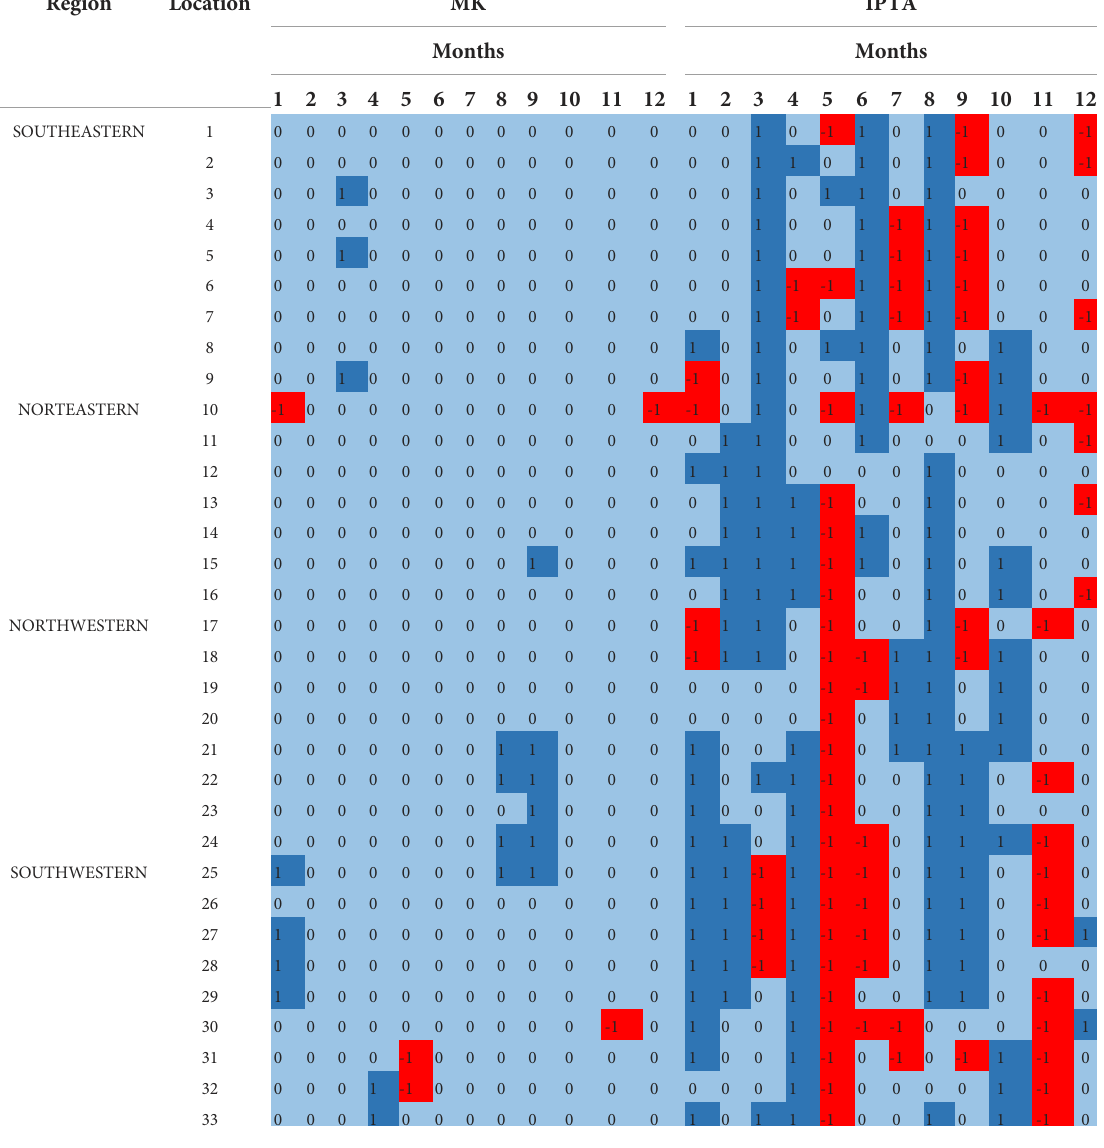
TABLE 2 Comparison of trend test results from different methods for maximum SWH.